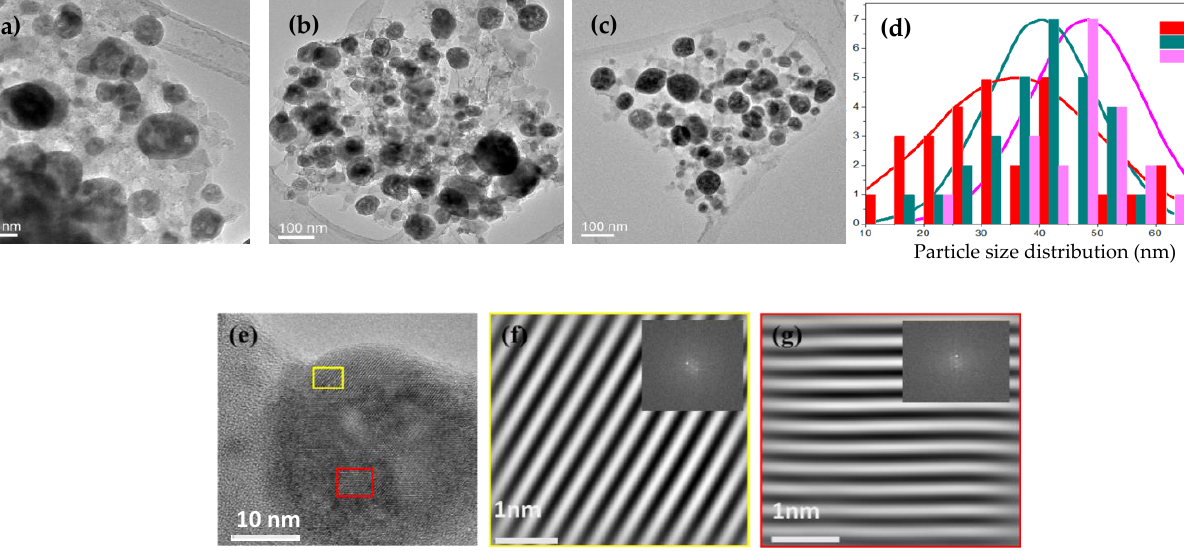
Figure 4. HRTEM of samples ( a ) GC-0.95, ( b ) GC-1.2 and ( c ) GC-1.5 treated at 650 ◦ C for 1 min; ( d ) particle size distribution for samples shown in Figure 4a–c; ( e ) HRTEM micrograph of GC-0.95 and transmission electron micrograph of ( f ) lattice plane of NaLaF 4 in the (101) direction with a distance of 0.31nm and ( g ) lattice plane of LaF 3 in the (011) direction with a distance of 0.32 nm.